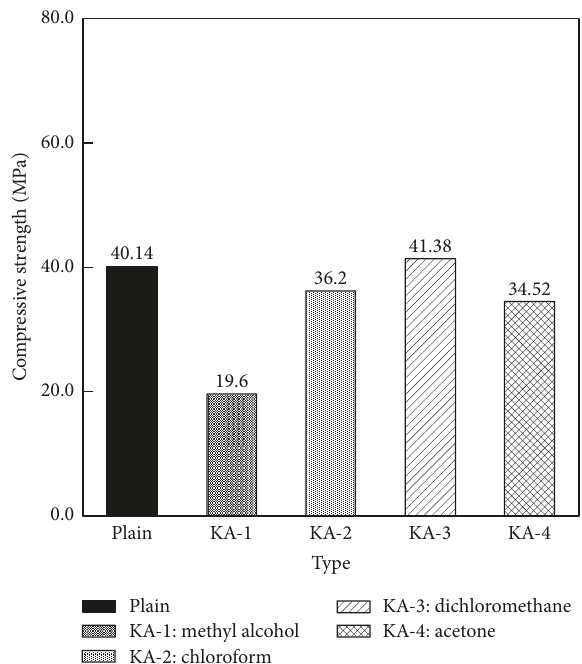
Figure 9: Compressive strength of core material according to KA type.